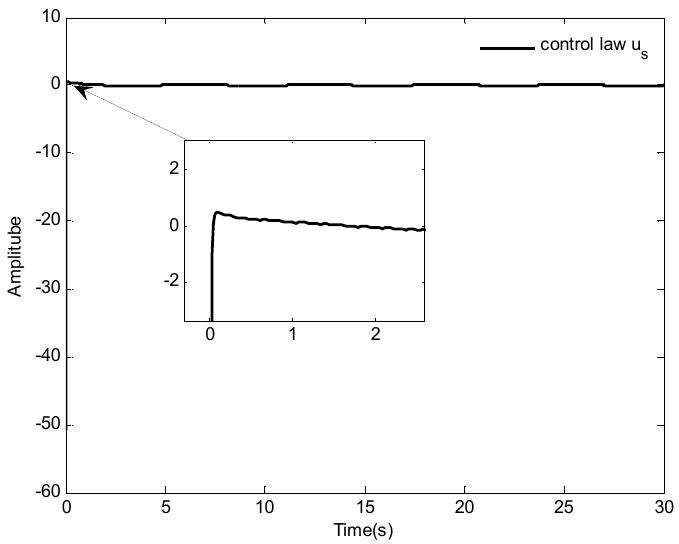
( t ) u t . Figure 17. The curve of control input u s s